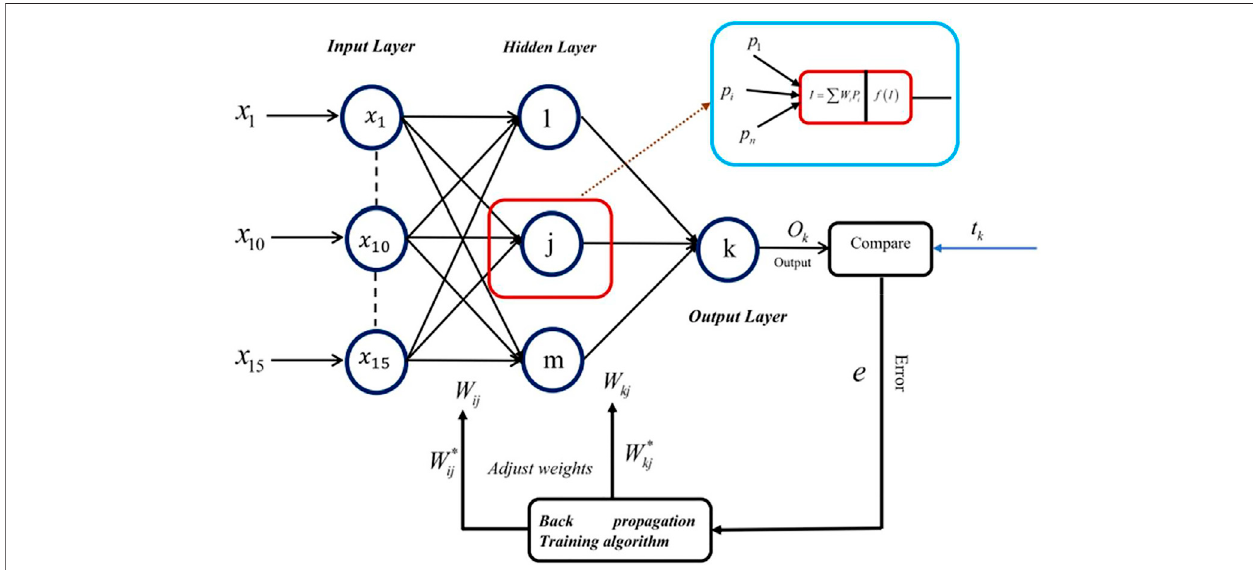
FIGURE 3 | Structure of FFNN with backpropagation algorithm.